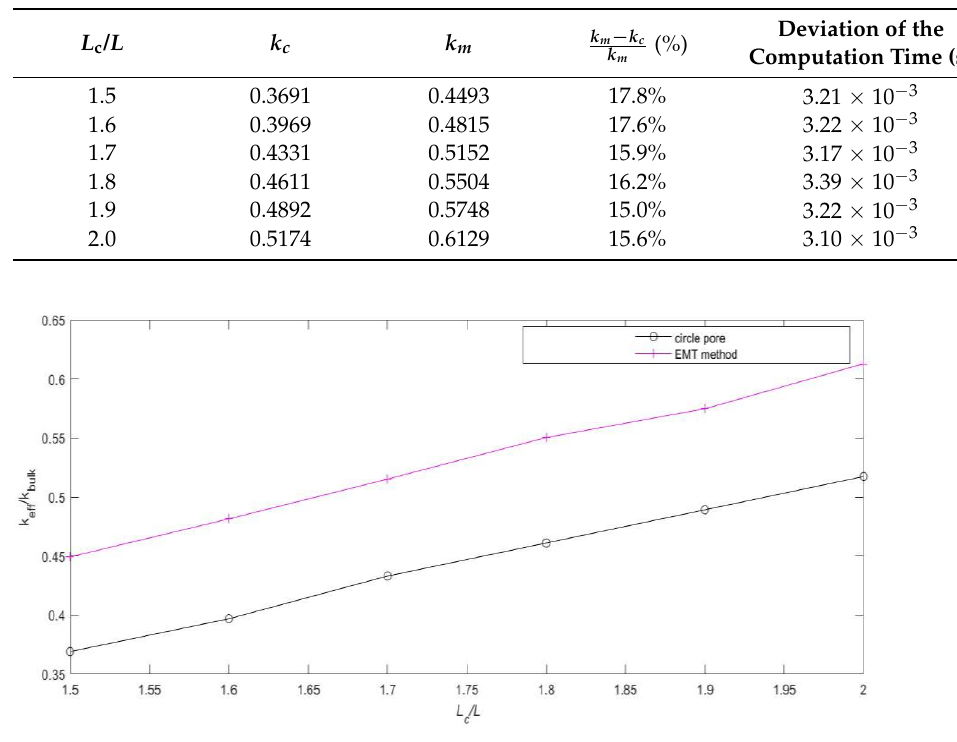
Figure 6. The effective thermal conductivity with the EMT method and the MCBU method with the changes of L c / L in circle pores.